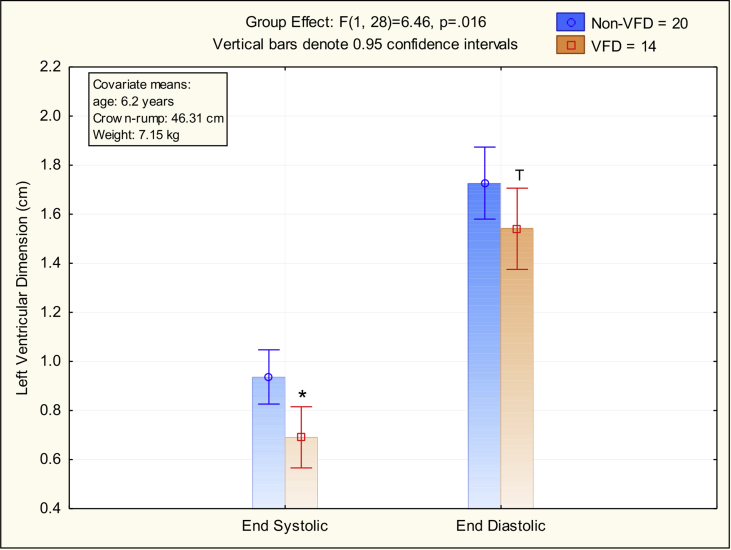
Comparison of Left Ventricular End-Diastolic (LVEDD) and End-Systolic Dimension (LVESD) Following Early Life Stress [Variable Foraging Demand-Rearing (VFD)].Using a general linear model, adjusting for sex, age, weight and crown-rump length, an overall rearing effect was noted [F(1,28) = 6.46; p = 0.02] indicating a lower overall dimension in the VFD-reared versus the normally-reared group. For univariate results, significant decrements [F(1,28) = 8.93, p = 0.006] in VFD for LVESD versus non-VFD were observed but were not significant (trend)for LVEDD [F(1,28) = 2.89, p = 0.10].